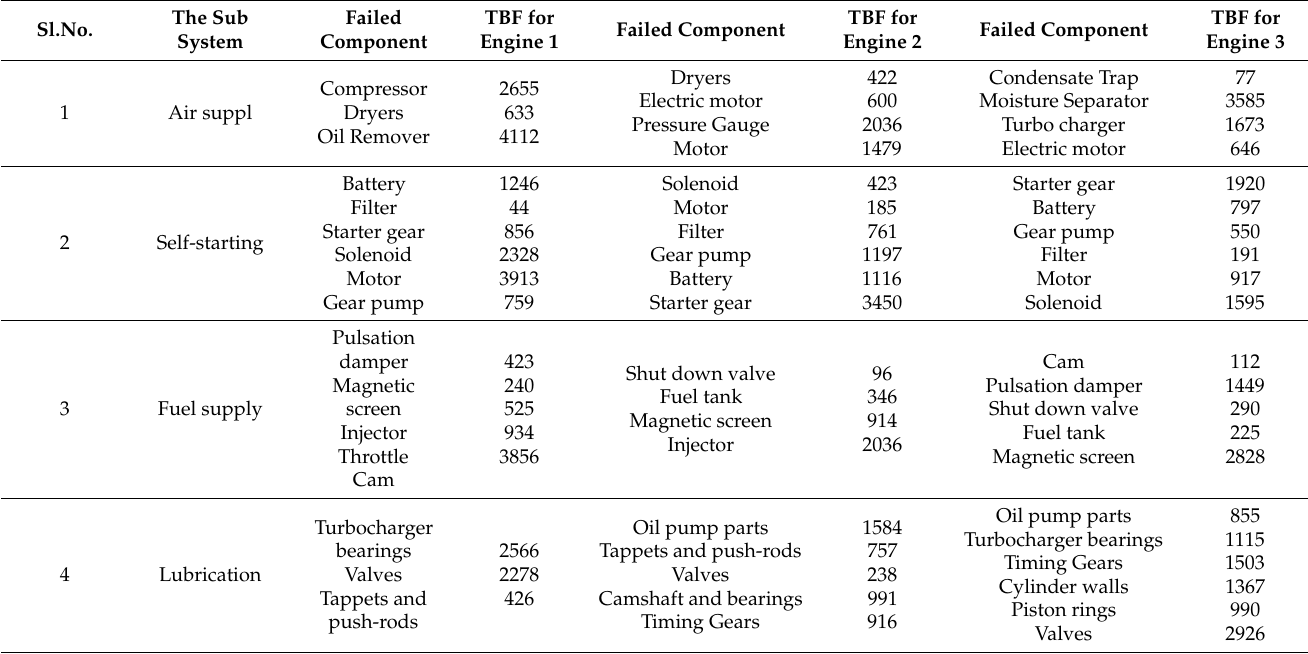
Table 1. TBF data (in hours) of engine subsystems of three